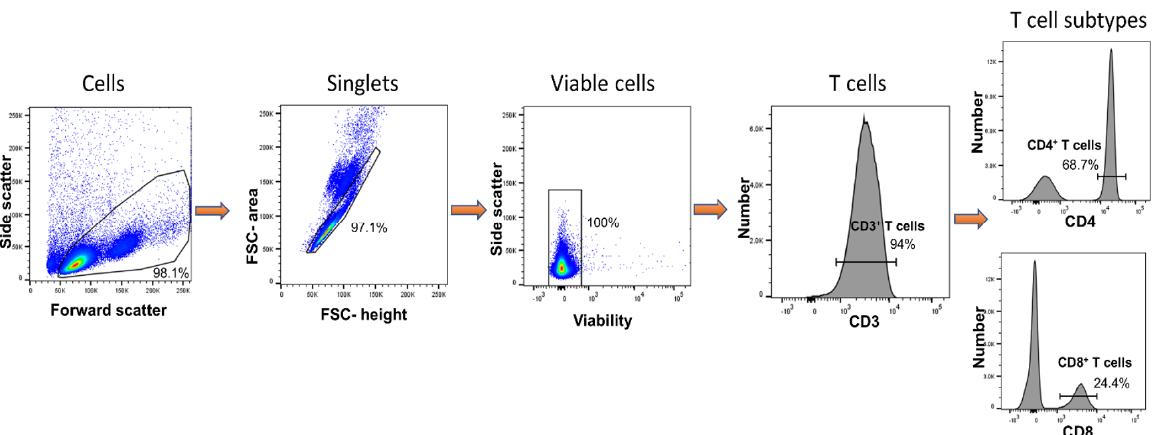
Figure 4. Purification of Total CD4 + and CD8 + T cells from fresh PBMCs. Total T cells were purified on day 0 from PBMCs and identified using side/forward scatter properties, doublet discrimination and total viable cells. Total CD3 + T cells were subdivided using CD4 and CD8 markers to distinguish between CD4 + and CD8 + T cells, respectively.